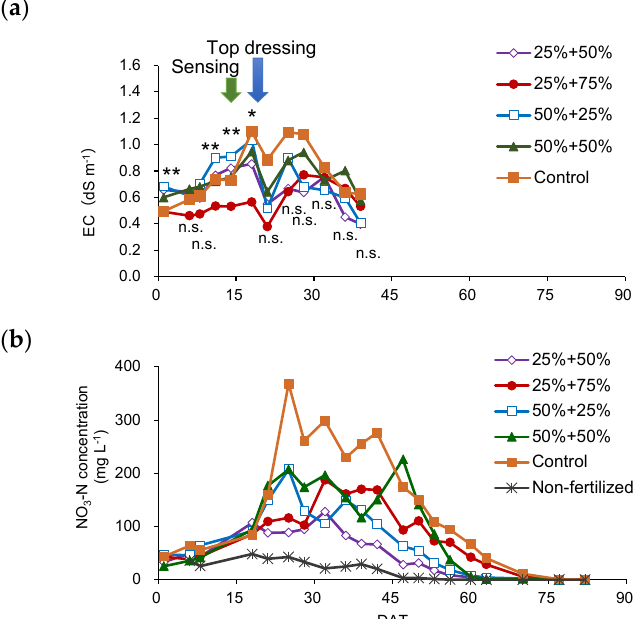
Figure 5. EC measured by the CS ( a ) and nitrate concentration in soil solution ( b ) (Trial 3). Values represent the mean values obtained from three replicates. Asterisks indicate significant differences: * p < 0.05 and ** p < 0.01. n. s. indicate no significance ( p > 0.05). Nitrate concentration: no significant difference for all days except in the non-fertilized plot.